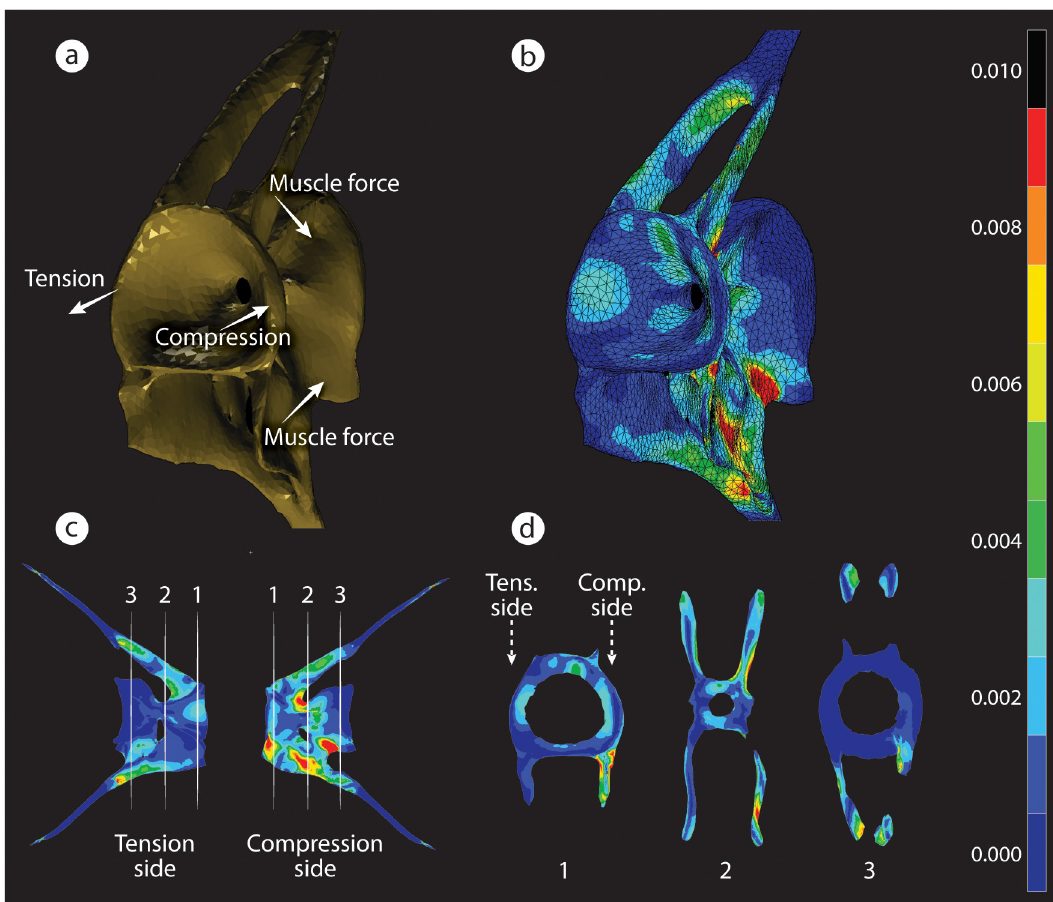
Fig 3. FEA of strain distribution in a loaded medaka vertebra. (a) A simplified loading graphic of the forces applied to the model. Lateral bending of the vertebral column during oscillatory swimming creates forces on the flat articular surfaces of adjacent centra, F Comp. on one side and F tens. on the opposite side. F Muscs acting on fish vertebrae are rather difficult to model because of the high complexity of the musculature as shown in S1 Fig and are represented here in a simplified manner. (b) 3D representation of von Mises strains in the vertebra. (c) Strain distribution in 2 contralateral views of a loaded vertebra. Locations of several transverse sections are marked by white dashed lines and are shown in (d). (d) Strain distribution in the 3 numbered 2D transverse sections shown in (c). Peak strains occur primarily near the external surfaces of the VB. Strain magnitudes (no units) for all images are shown in the color bar on the right. F Comp., compression force; FEA, finite element analysis; F Musc, muscle force; F Tens., tension force; VB, vertebral